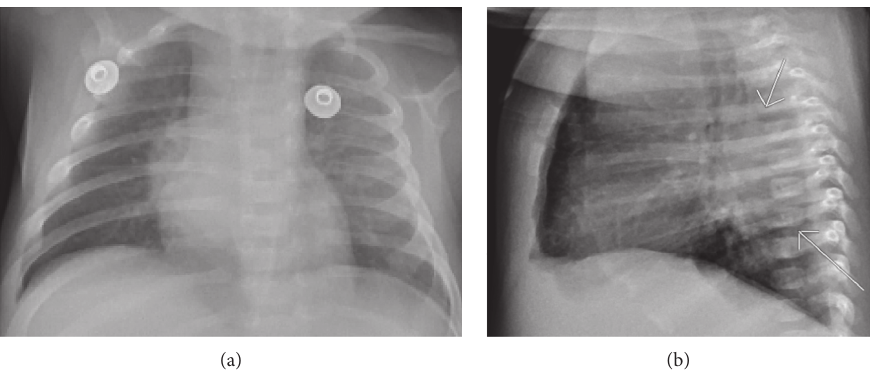
Figure 1: (a) Chest radiograph showing focal airspace opacity projecting over the right midlung zone. (b) Lateral CXR of “well-defined right lower lobe opacity interpreted as pneumonia versus